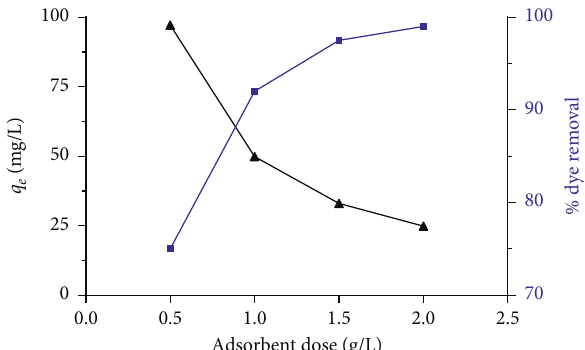
Figure 4: Percentage removal efficiency of BG and the amount adsorbed as a function of the adsorbent dose. Adsorbent amount range: 0.5–2g/L, pH: 6.8, initial dye concentration of dye: 50mg/L, V � 200 mL, T : 25 ° C, and contact time: 15min.